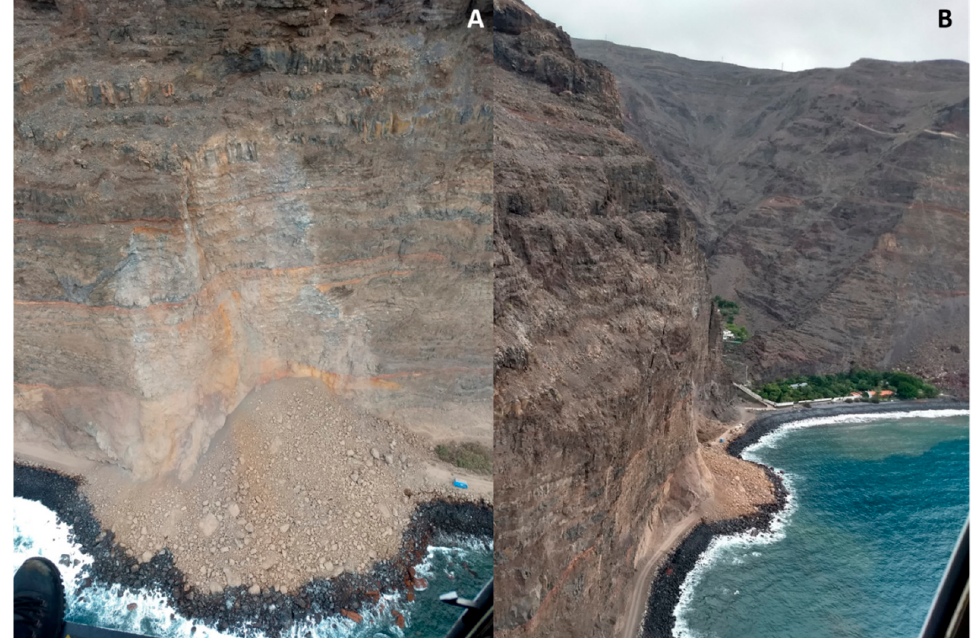
Figure 2. Rock fall of 14 November 2020 in La Gomera Island: ( A ) Scarp and deposit (see the blue van as scale); and ( B ) The rock fall deposit and the Argaga beach in the background.